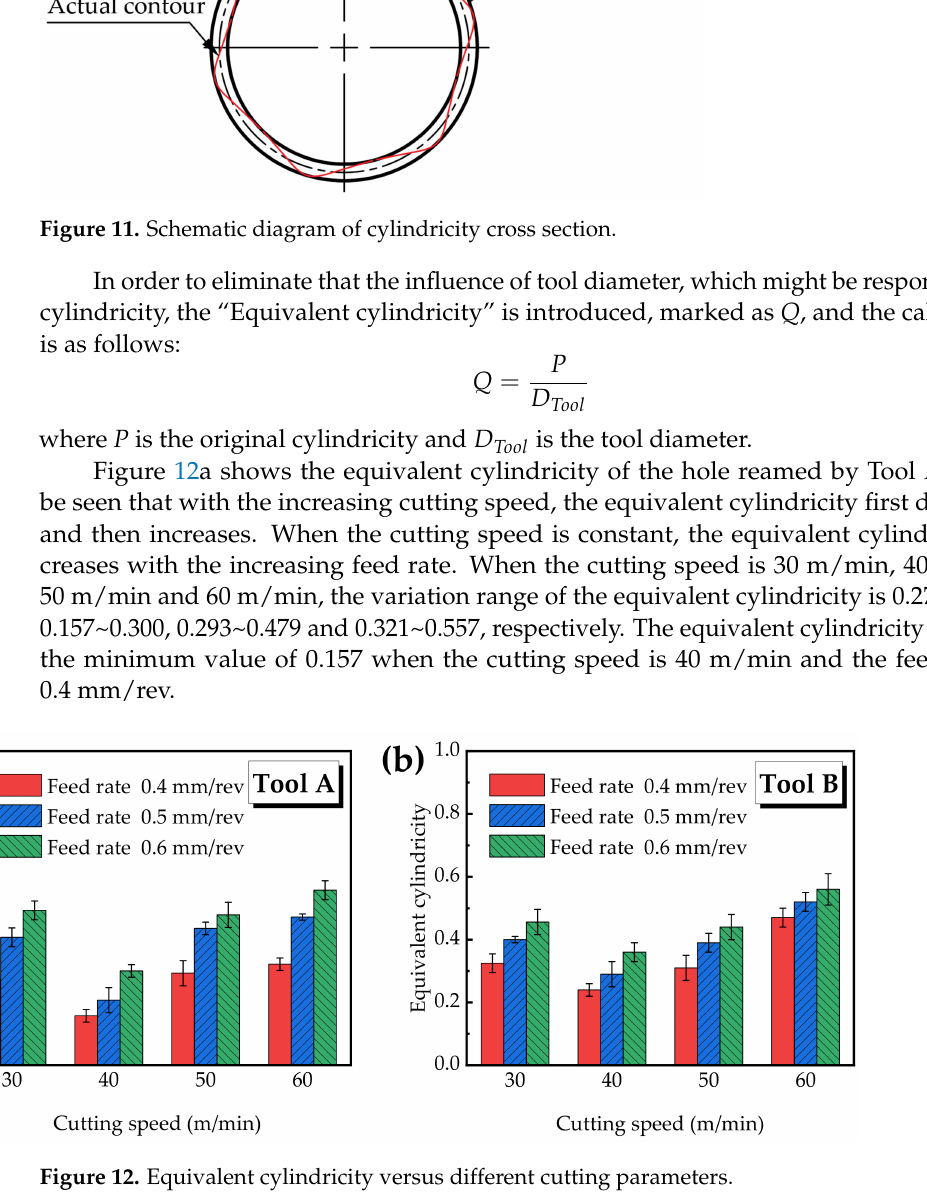
Figure 12. Equivalent cylindricity versus different cutting